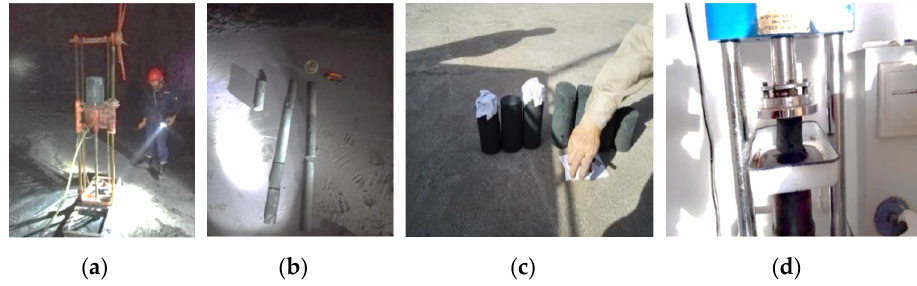
Figure 22. Drilling core verification of in situ backfill strength: ( a ) Drill sampling; ( b ) Sample of